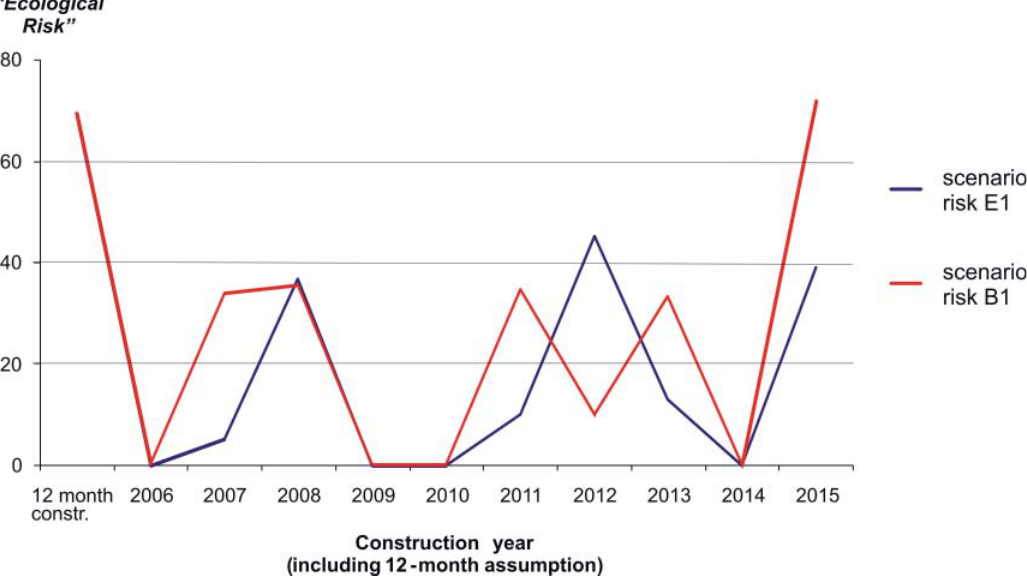
Figure 6. ‘Ecological risk‘ of offshore wind farm construction scenarios up to the year 2015. Years during which construction takes place present an increase in risk, with respect to the actual situation (2006) with no construction. Maximum risk levels are found in the reference situation, assuming construction to take place for a period of 12 months in box 58, a considerable area in the Elbe Box, and also for scenario B1 in year 2015, where construction takes place in an area covering about 60% of the Elbe